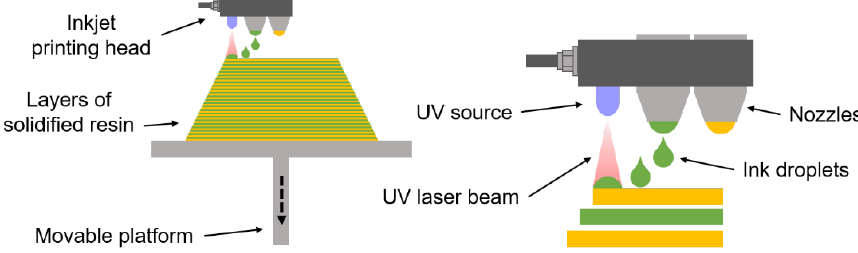
Figure 8. Schematic of a typical CIJ printing method.